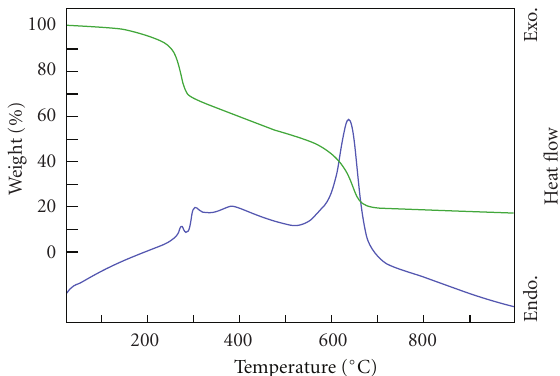
Figure 4: Thermogravimetric di ff erential thermal analysis of SPES